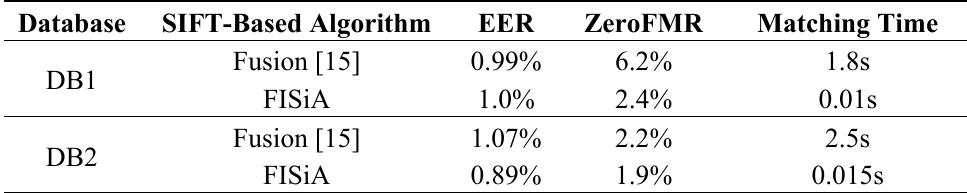
Table 4. Comparison with other SIFT-based fingerprint matcher on FVC2002.